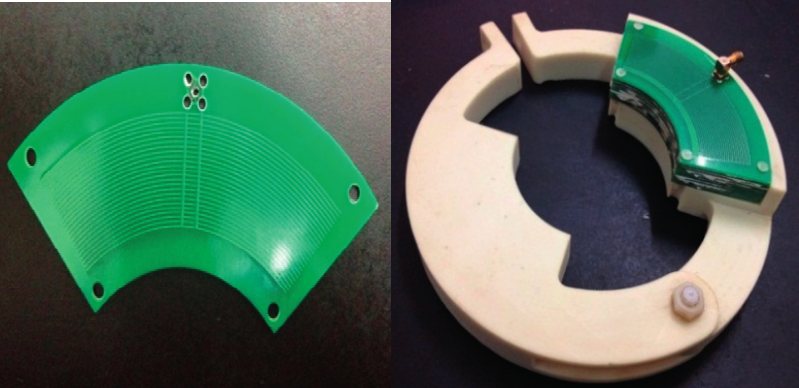
Figure 8. Real sensor